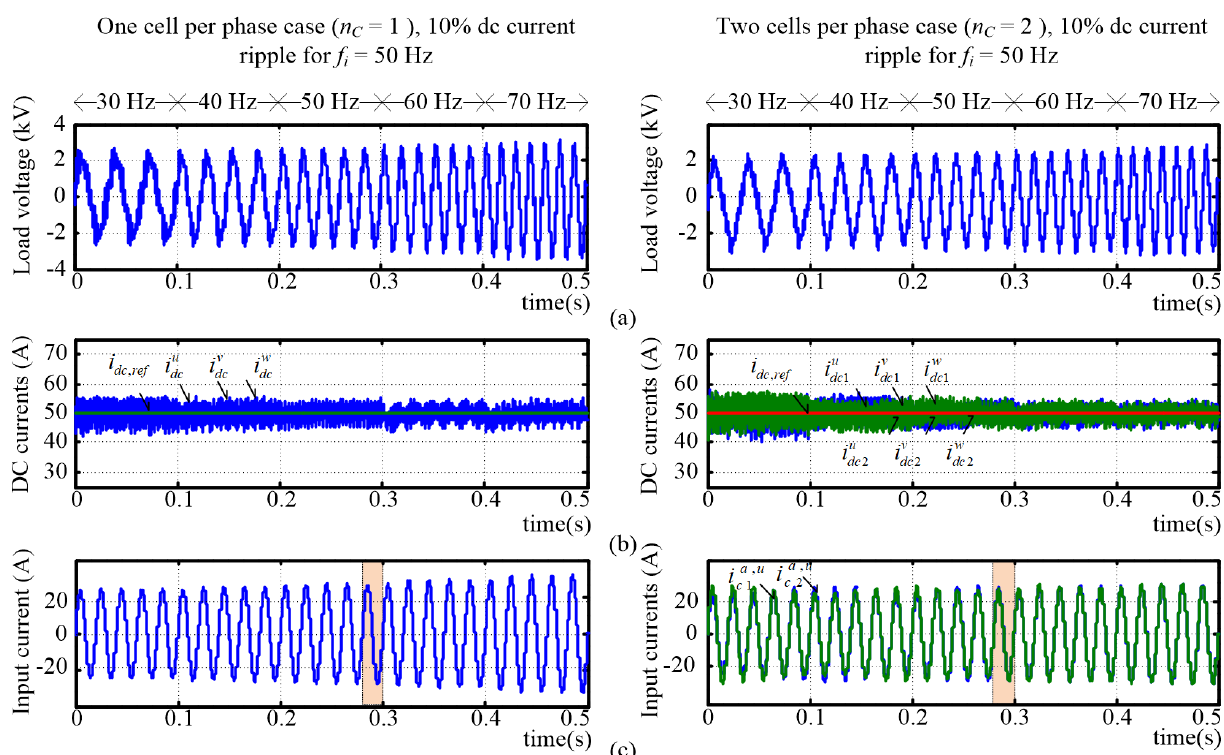
Figure 6. Performance under inverter frequency changes: ( a ) load voltage; ( b ) DC currents in each cell; ( c ) cell input current.